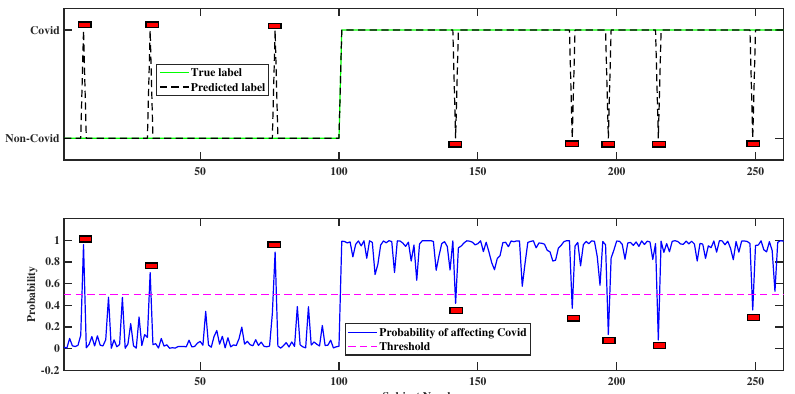
Figure 7. Development of a DSS using a HHO–based